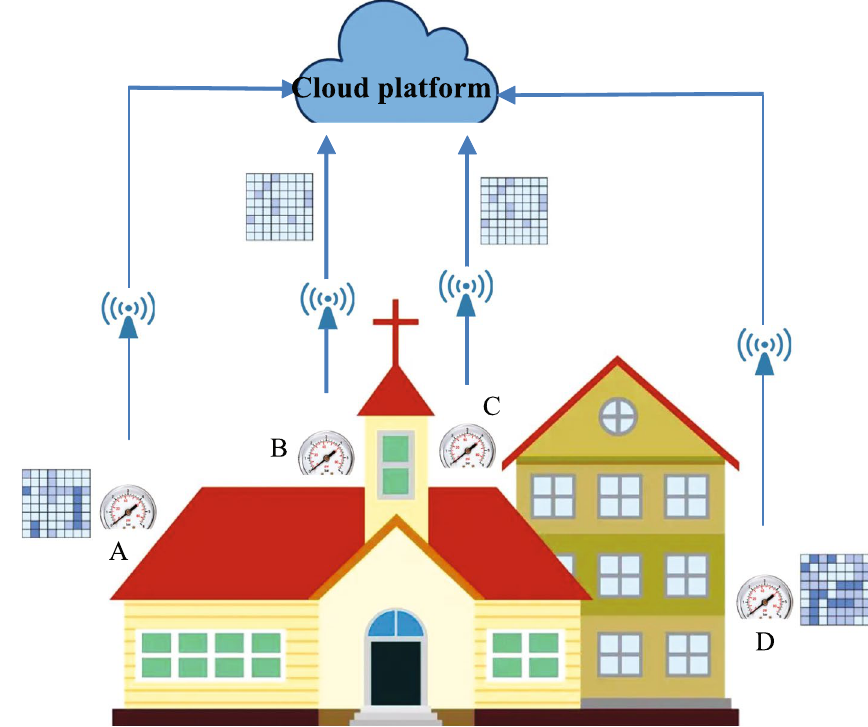
Fig. 1 Cloud sensor-based smart building: an example scenario and